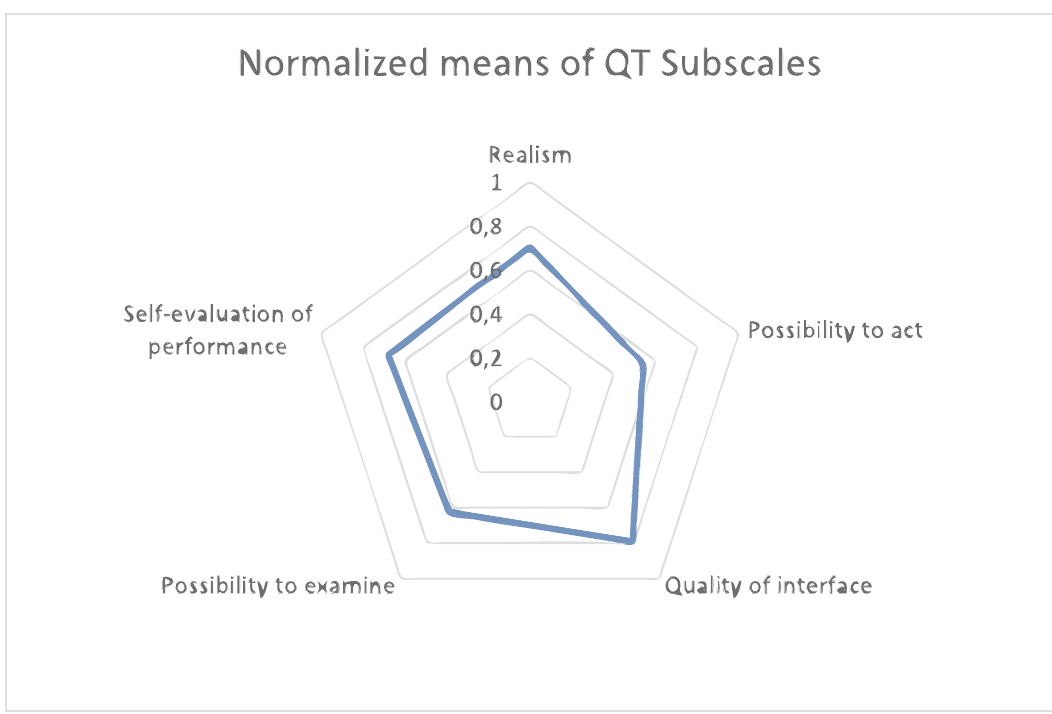
Fig 7. Radar plot of normalized means of PQ subscales assessment.